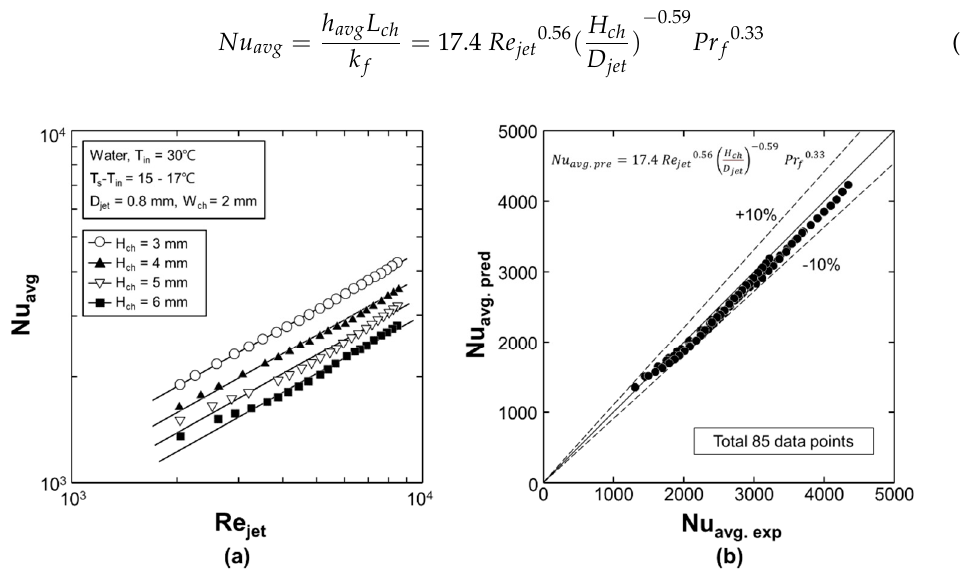
Figure 6. ( a ) Experimentally measured average Nusselt number; ( b ) comparison between experimentally measured average Nusselt number and new correlation.